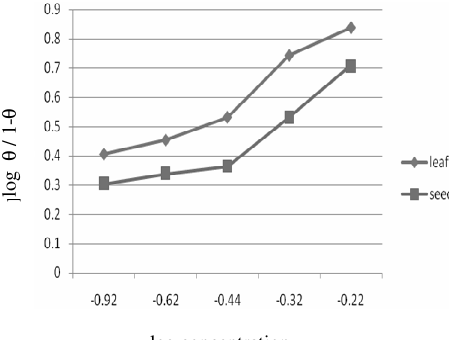
Figure 2. Langmuir adsorption isotherm of SO leaves extract for aluminium in 1.0N H 2 4 with inhibitor